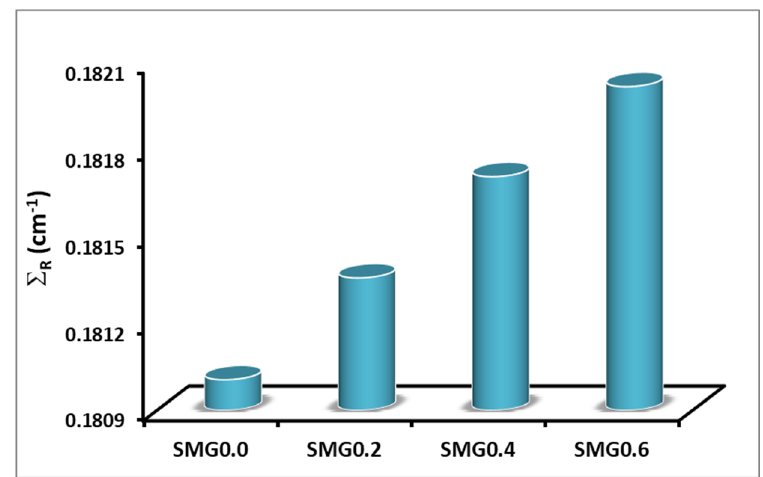
Figure 17. Effective removal cross section of samples for fast neutrons.